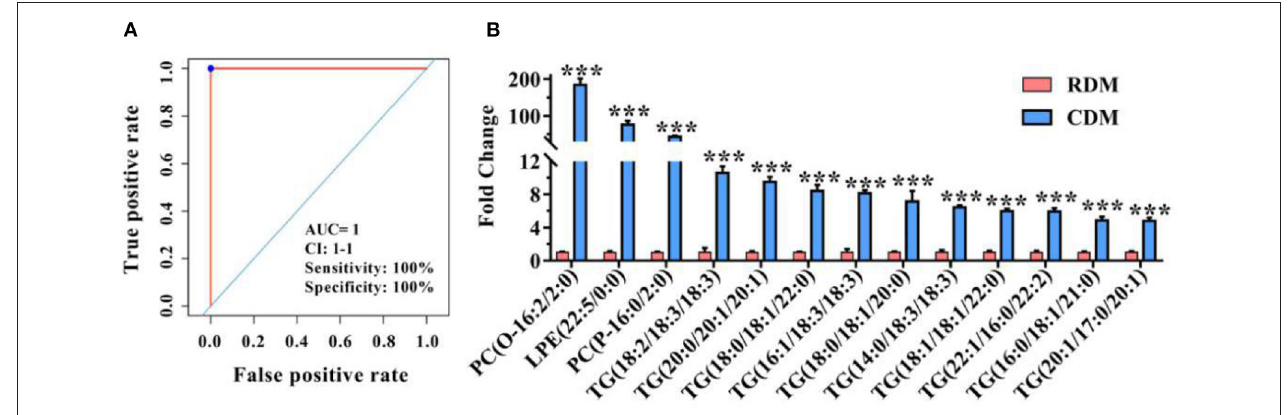
FIGURE 6 | Potential lipid markers in cooked and raw donkey muscles. (A) Receiver operating characteristic curve of (B) . (B) Fold changes of potential lipid markers in CDM vs. RDM. Data are presented as means ± SEM ( n = 6), *** p < 0.001. AUC is the area under the ROC curve; CI 1–1 is the lower and upper limit of the AUC confidence